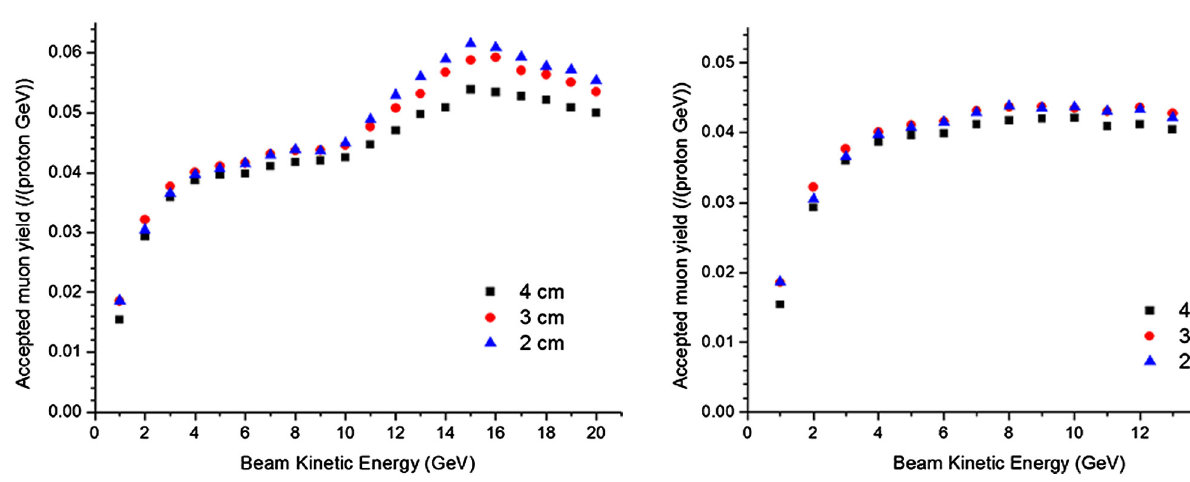
FIG. 13. Same as for Fig. 11 except for choosing INCL model for all